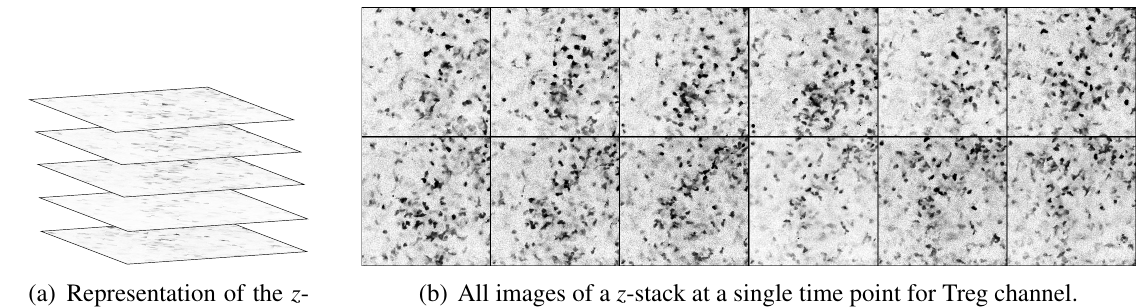
Figure 7: The z -stack representation and corresponding images for channel with Treg cells.